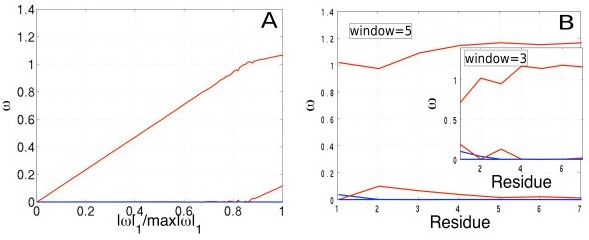
Performance analysis. A) Regularization path for the ensemble (|ω|1 → 0 as λ → ∞ towards left). B) Residue-level lasso with varying window sizes centered on each residue (λ = 10). The color code is the same as in Fig 2.